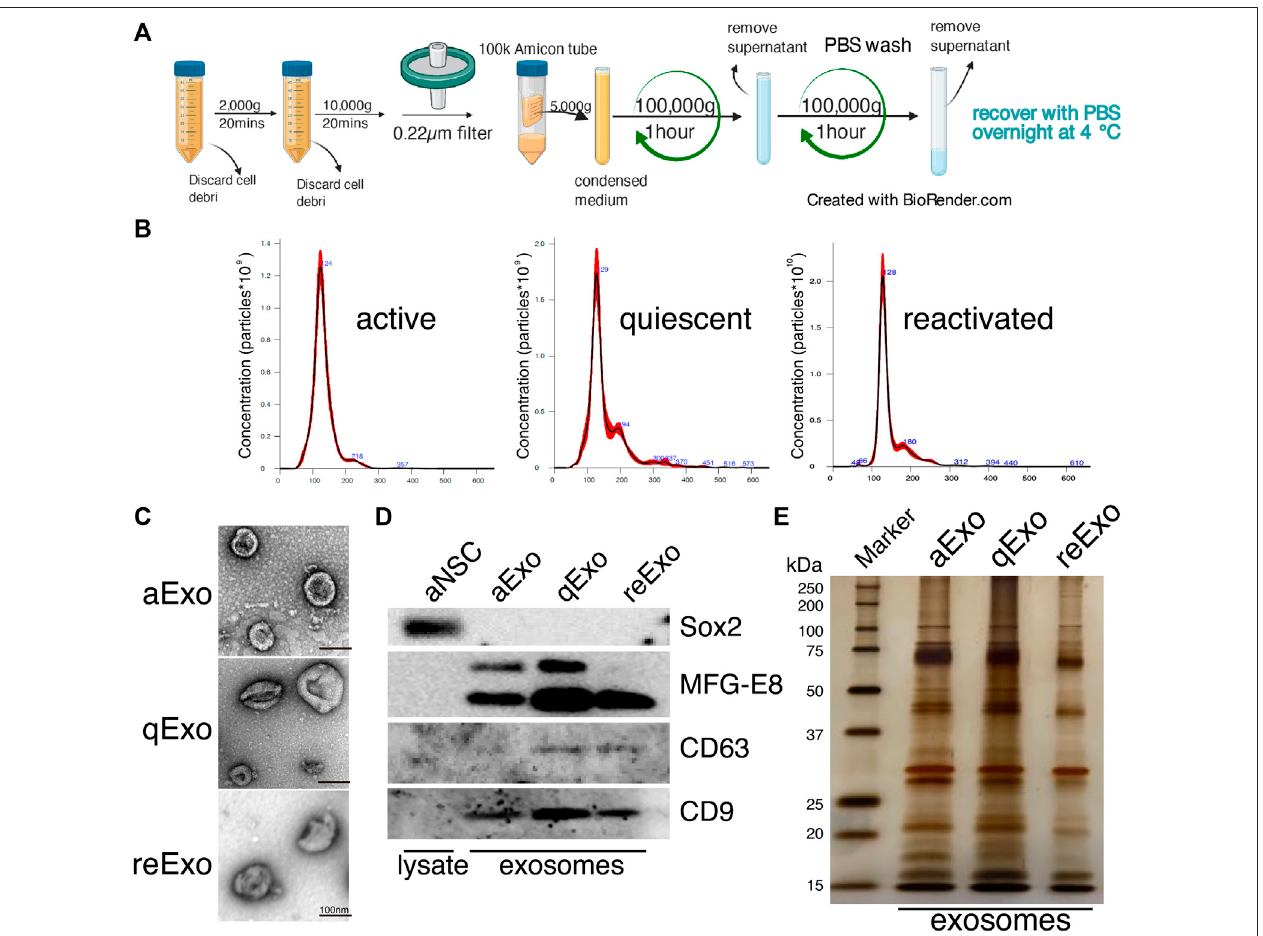
FIGURE1| NSCexosomescollectionandqualityexamination. (A) Exosomecollectionwork fl ow. (B) Exosomesizedistributionandconcentration.Exosomeswere prepared from media for 2, 3 d, and 2 d incubation ofactive, quiescent, and reactivating NSCs, respectively. Averaged fi nitetrack length adjustment indicates exosome concentration and size, and was examined by NanoSight( n (cid:2) 5). X -axis is vesicle size and y -axis is vesicle concentration. Numbers (blue) areapproximate vesicles sizes at peak vesicle concentrations. (C) Transmission electron microscopy images of aExo, qExo, and reExo. Scale bar (cid:2) 100 nm. (D) Total cell lysates and exosomes were subjected to WB of Sox2, MFG-E8, CD9, and CD63. MFG-E8 showing two bands indicating two variants. (E) Silver staining of exosome samples (0.4 µg). Left lane: molecular weight marker.